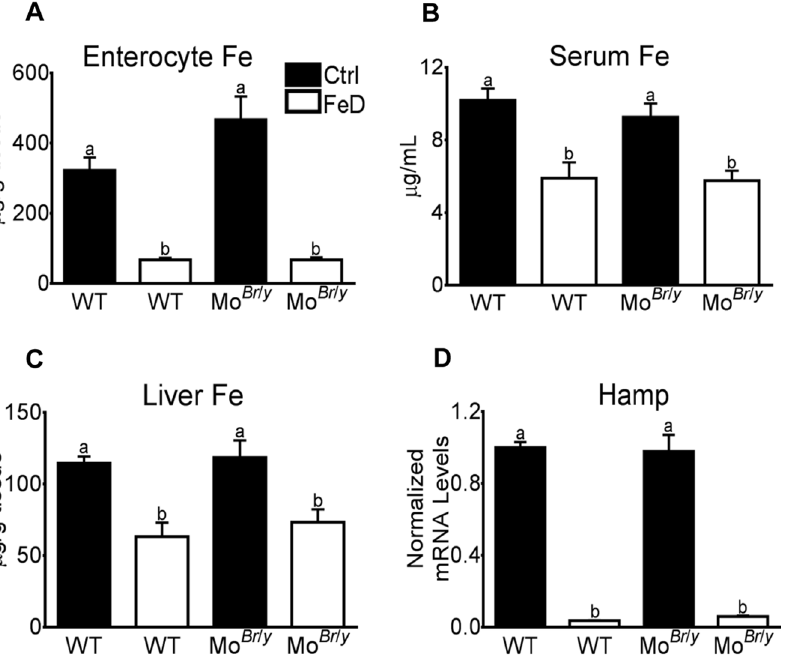
Figure 2. Tissue Fe levels and hepatic hepcidin (Hamp) gene expression. Iron levels were determined as described in Methods . Results are depicted graphically, with filled bars representing data from mice fed the control diet and open bars depicting data from FeD mice. Genotype is indicated beneath each bar. Iron levels were normalized by mass of tissue or volume of serum. ( A ) Enterocyte Fe content, n=3 per group; ( B ) Serum Fe content, n=4 for WT mice and 3 for Mo Br / y mice; ( C ) Liver Fe content, n=10 mice per group. Also depicted is hepatic Hamp mRNA expression ( D ), normalized to cyclophilin mRNA levels (which did not vary significantly). n=8 per group. a,b Statistically different from one another within each panel ( p , 0.05). WT, wild-type. Bars (A–D) depict mean 6